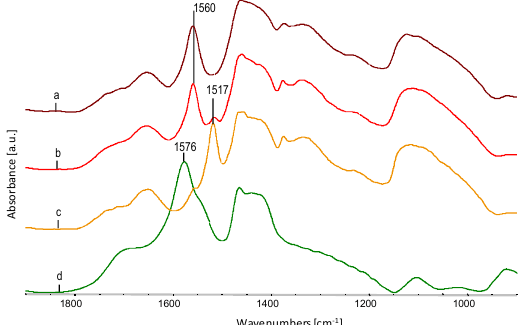
Figure 12. Comparison of spectra of B series fibres saturated with AgNO 3 and reduced to AgNPs and after extraction in water and sodium stearate: ( a ) spectrum for B0.2, ( b ) spectrum for B1.0, ( c ) spectrum for B5.0, ( d ) spectrum for sodium stearate.